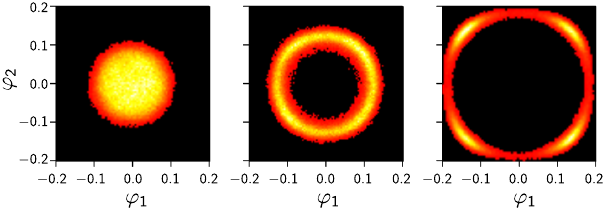
FIG. 4. Probability distribution of ~ φ ¼ ð φ 1 ; φ 2 Þ for size L ¼ 64 and (from left to right) J ¼ 0 . 0886 , J ¼ 0 . 091 , and J ¼ 0 . 096 , corresponding, respectively, to the critical point, the VBS phase in the U(1) regime, and the VBS phase in the Z 4 regime. The crossover from U(1) to Z 4 symmetry is analyzed further in Sec. IV B.